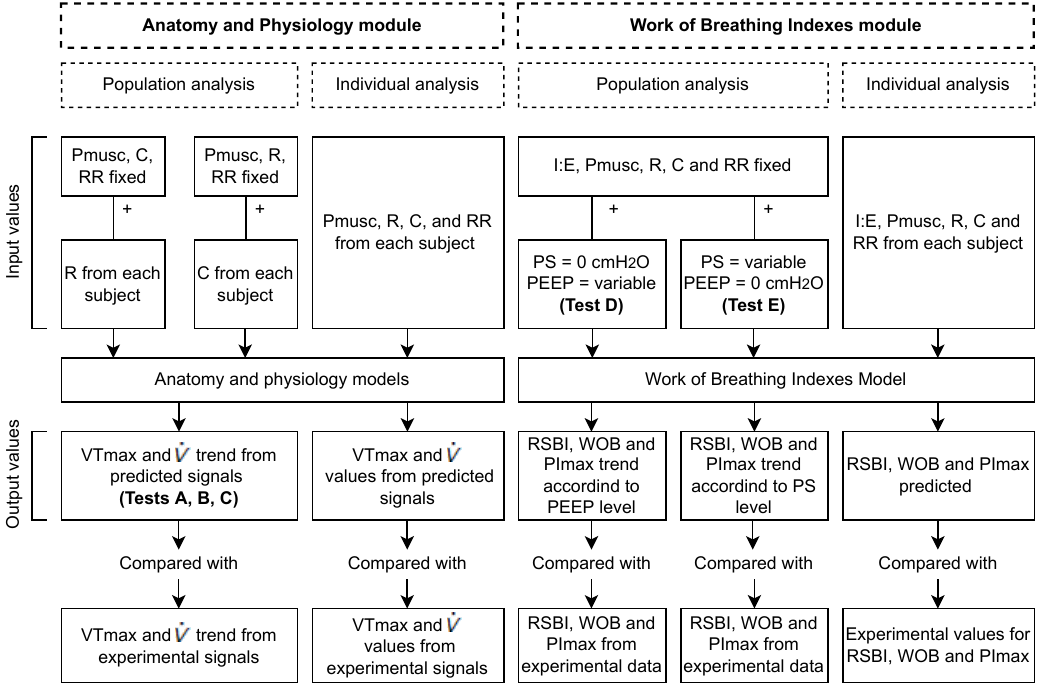
Figure 4. Methodology diagram for the statistical validation of both modules for the population and individual analyses, which differ in the input values and the comparison